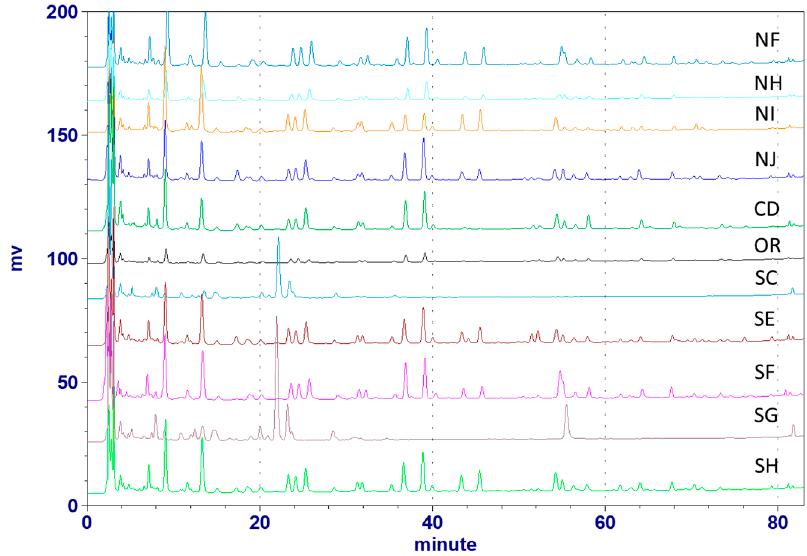
Figure 6. HPLC profiles of Astragali Complanati Semen samples collected from the North, Middle, and south of Taiwan (254 nm).